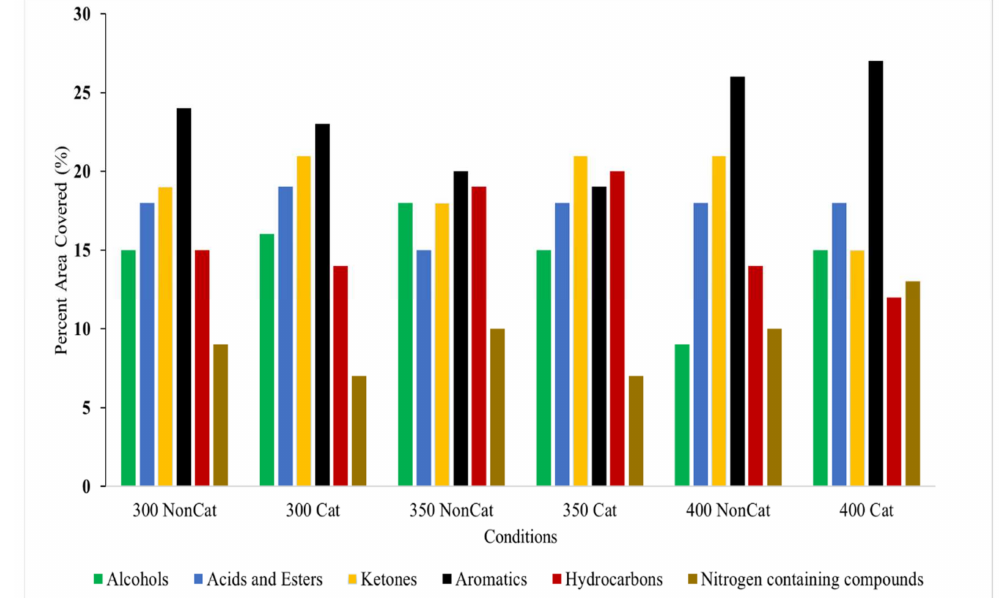
Figure 5. Distribution of Organic